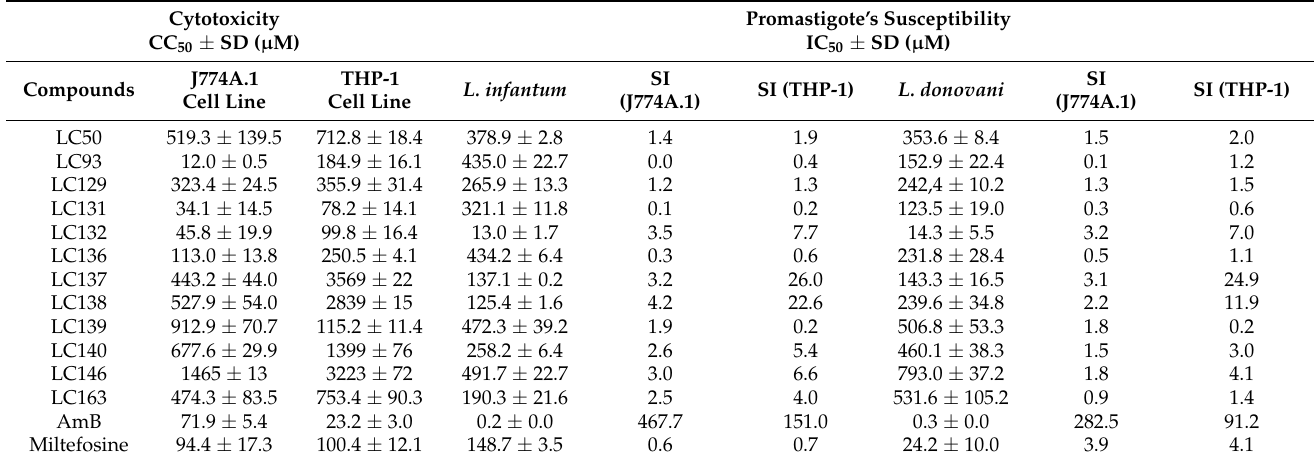
Table 1. CC 50 , IC 50 and SI of synthetic trioxolanes, amphotericin B and miltefosine, against J774 A.1, THP-1 cell lines and the promastigote forms of L. infantum IMT 151 and L. donovani BD14 after 48 h incubation.